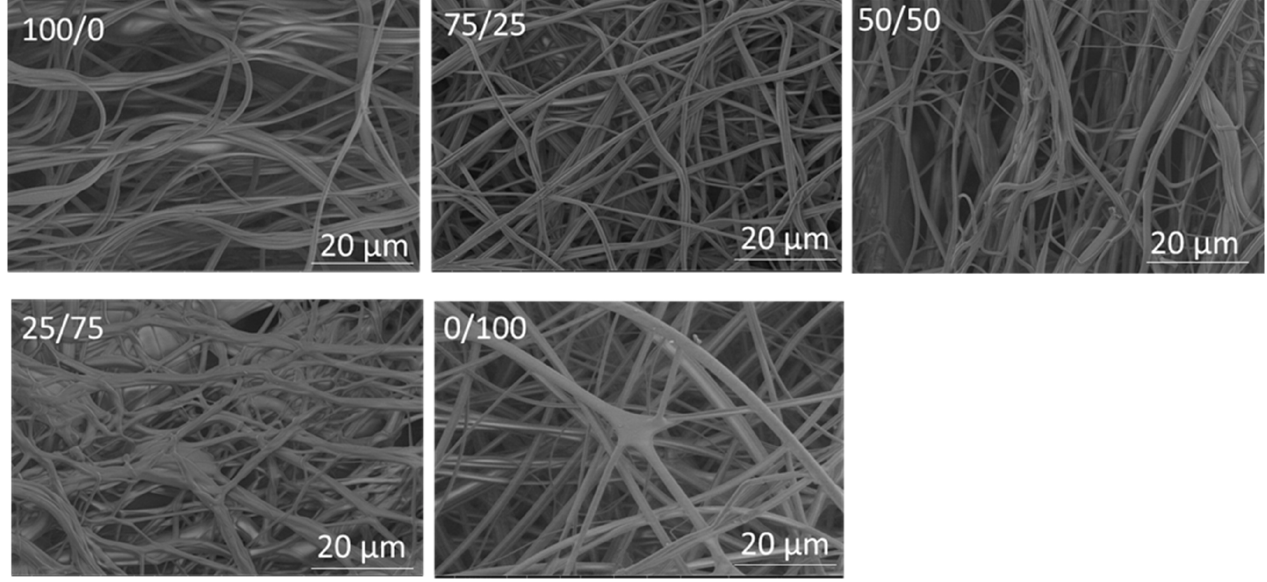
Figure 3. SEM images of PVA, PVP, and PVA/PVP nanofibers with different PVA/PVP ratios.